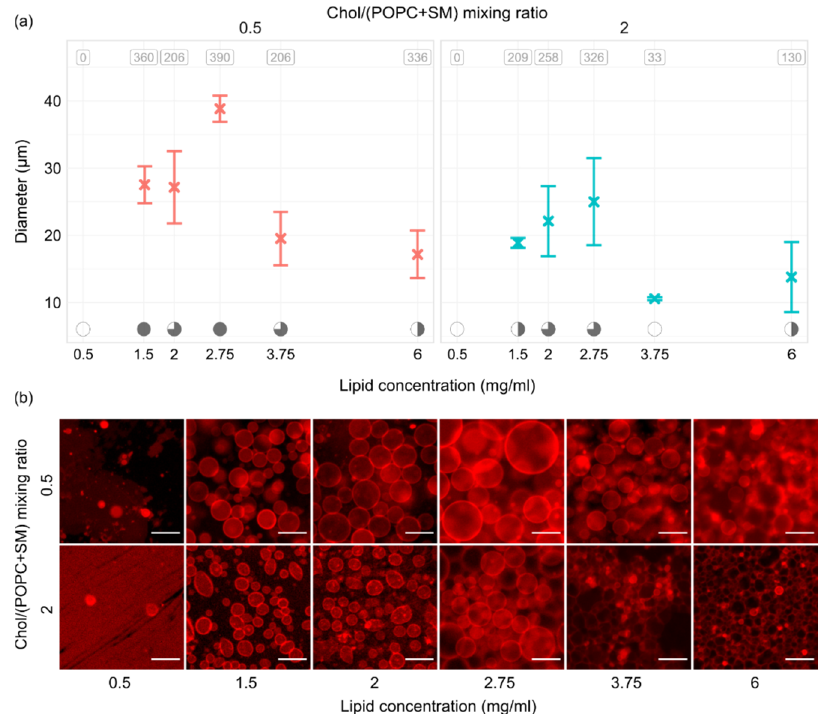
Figure 5. ( a ) GUV size depending on the thickness of the lipid film and Chol/(POPC + SM) mixing ratio. All of the experiments were performed using a frequency–voltage combination of 10 Hz–2 V. At the top of the panels, the average number of tracked vesicles per sample is displayed. Electroformation successfulness is displayed at the bottom of the panels. Successfulness takes into account the yield and size of GUVs and the amount of defects. It is displayed here through circle fullness, where a fuller circle indicates better successfulness. Empty circles denote that no GUVs were formed or electroformation efficiency was very low. ( b ) Representative fluorescence microscopy images for conditions displayed in the panels above. The scale bar in the bottom right of the images denotes 50 µ